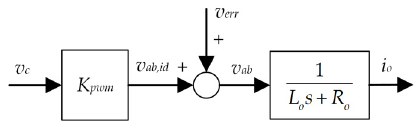
Figure 6. Transfer function of the ARSI.